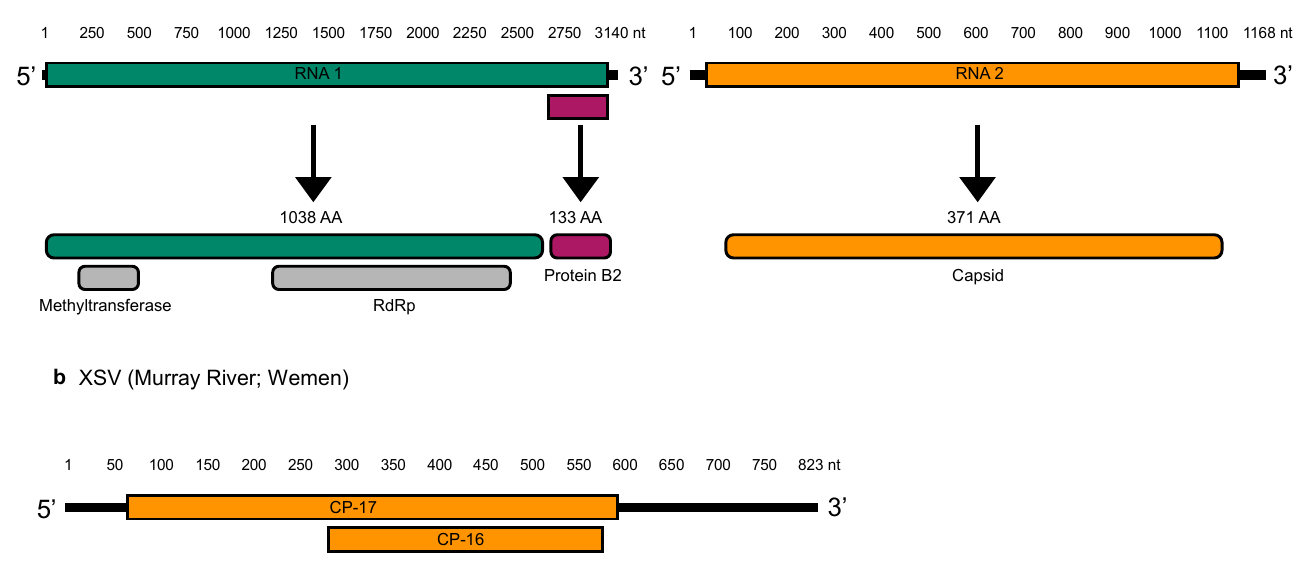
Figure 3. ( a ) Genome organization of novel MrNV detected at the Murray River (Wemen) site. Top bars represent RNA1 and RNA2 segments, with arrows showing encoded proteins and amino acid length. Grey bars represent conserved domains along with RdRp ORF. ( b ) Genome organization of XSV. Orange bars illustrate overlapping genes of structural proteins CP-17 and CP-16. The MrNV genome from the Murray River (Wemen) site was selected for illustration purposes as this was the only library that also contained the satellite virus, XSV.